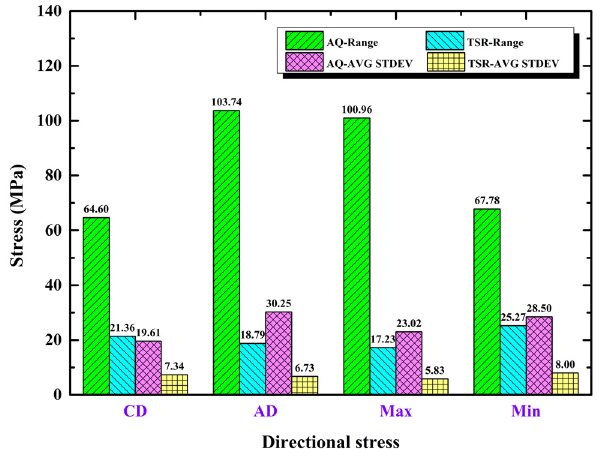
Figure 4: Comparison of ranges and average standard deviations of residual stresses between the AQ piece and the TSR piece. ( 1 ) CD: circumferential residual stress, ( 2 ) AD: axial residual stress, ( 3 ) Max: maximum principal stress, and ( 4 ) Min: minimum principal stress.